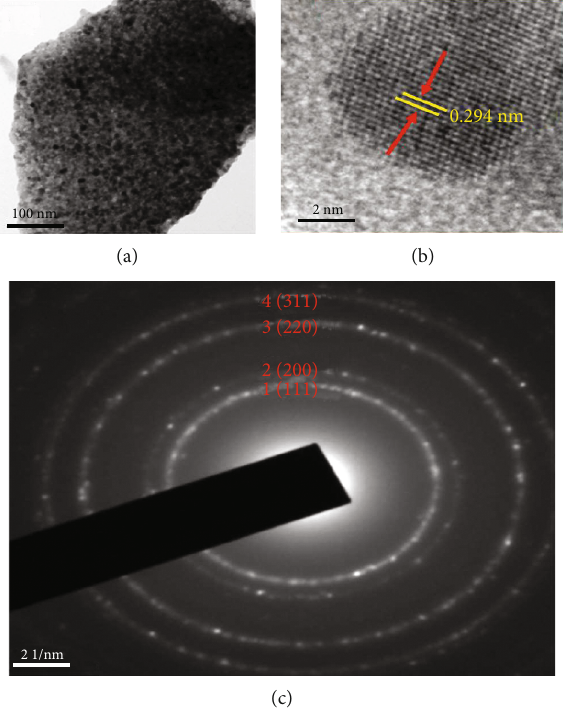
Figure 4: (a) TEM image, (b) HRTEM image, and (c) SAED pattern of ZrO the produced ZrO :Dy 3+ (3 mol percent), as shown in 2 Figure 6. The recorded wide spectrum of the NM displayed the existence of binding energies ~ 1072, ~ 537.6, ~ 292.2, and ~ 186.3 eV which corroborates to Dy 3d, O 1s, C 1s, and Zr 3d peaks, respectively.